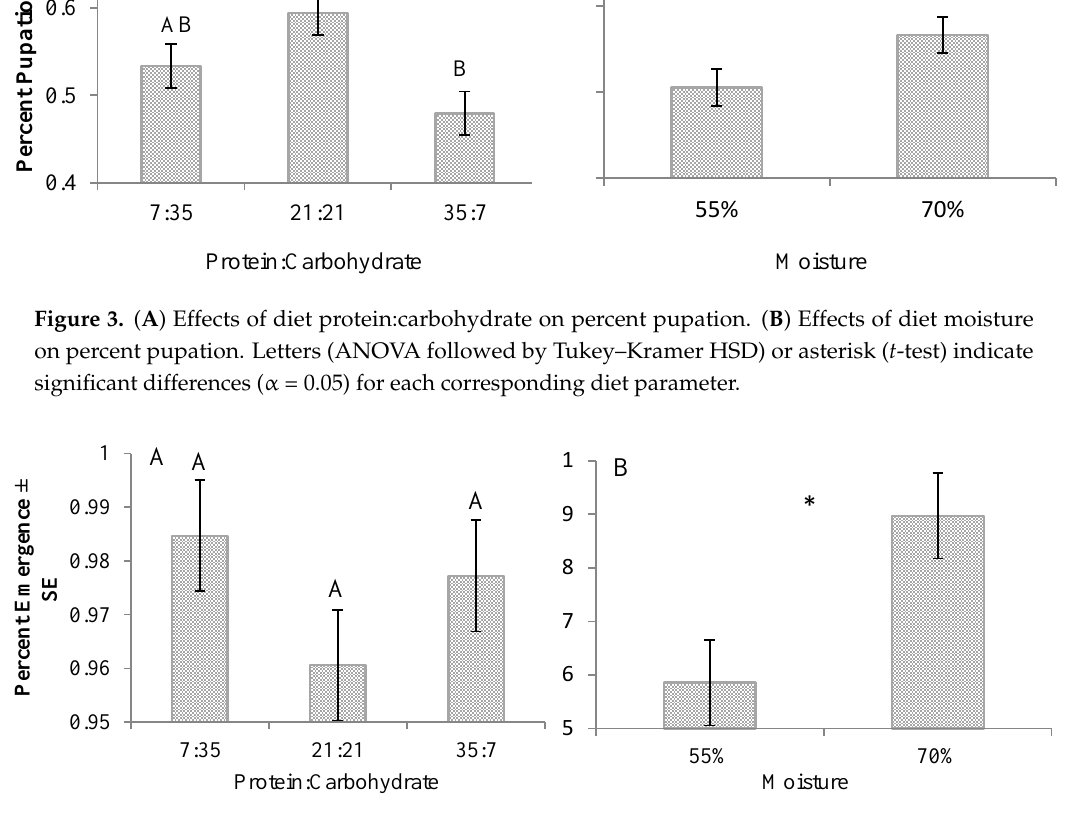
Figure 4. ( A ) Effects of diet protein:carbohydrate on percent adult emergence. ( B ) Effects of diet moisture on percent adult emergence. Letters (ANOVA followed by Tukey–Kramer HSD) or asterisk ( t -test) indicate significant differences (α = 0.05) for each corresponding diet parameter.